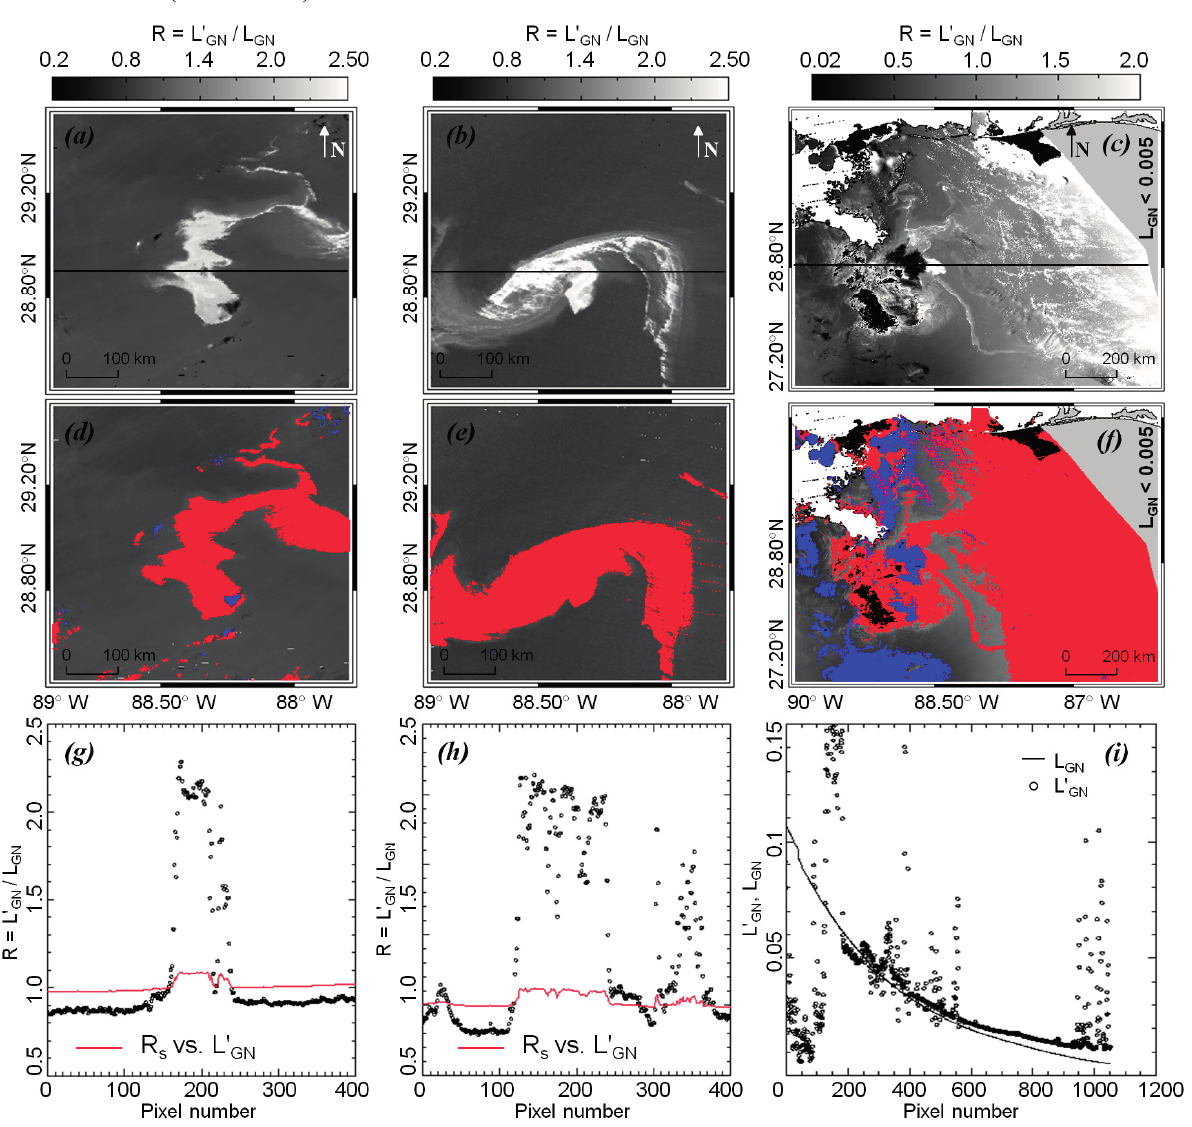
Figure 7. Oil spill R maps relative to the three validation scenes of Table 1 (Deepwater Horizon oil spill disaster of 2010): ( a ) 25 April 2010 (Scene 8); ( b ) 29 April 2010 (Scene 9); ( c ) 25 May 2010 (Scene 10); ( d – f ) the regions detected as probable oil spills, same scenes; ( g , h ) black dots are R values along transects indicated by black lines in (a,b), while red lines are R s values along the same transect, as inferred from the curves of Figure 6; ( i ) comparison between L GN (solid line: Cox and Munk (1954) isotropic) and L' GN (dotted line) along the transect in (c). Glint-free ( i.e. , L' GN < 0.005) areas are marked in grey in